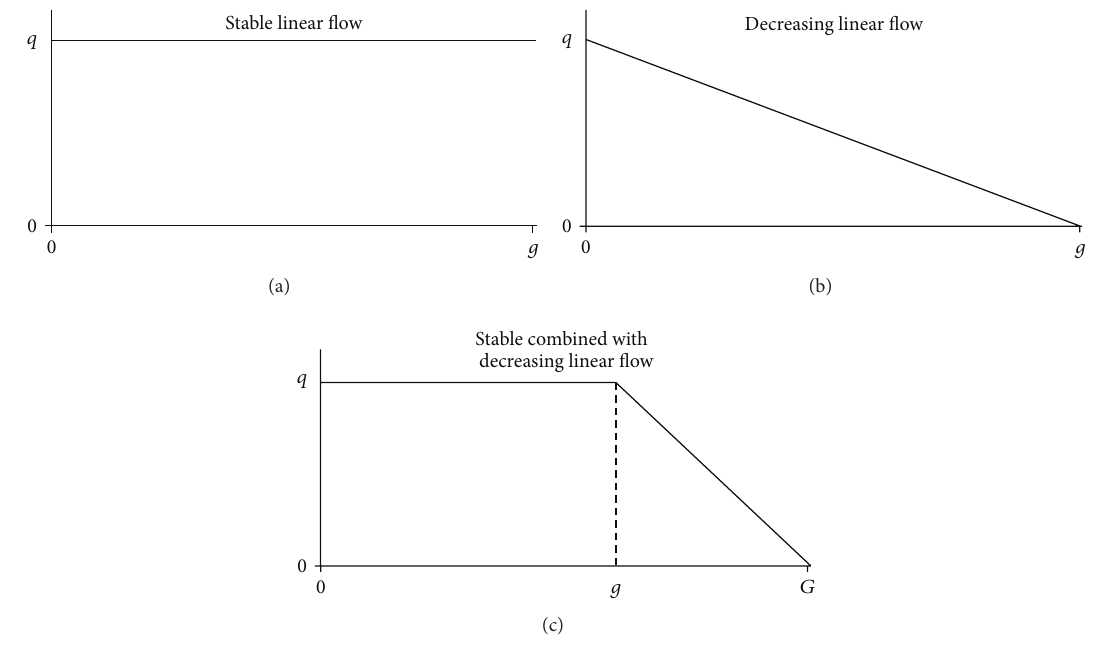
Figure 1: Three typical departing flow